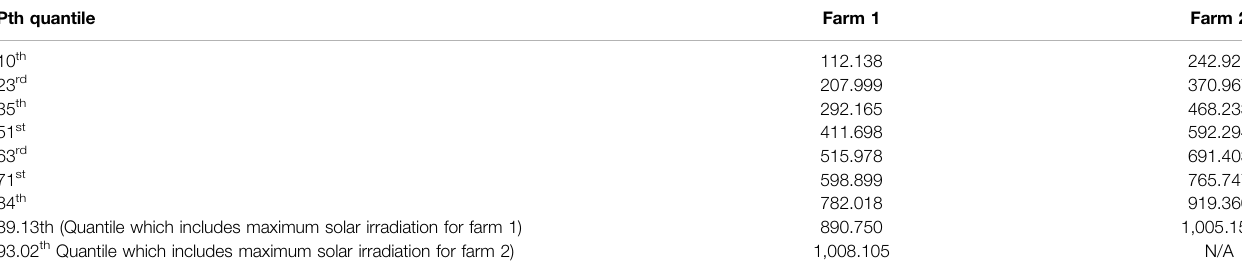
TABLE 2 | Quantile of Weibull for different farms and maximum irradiance value (W/m 2 ) present in